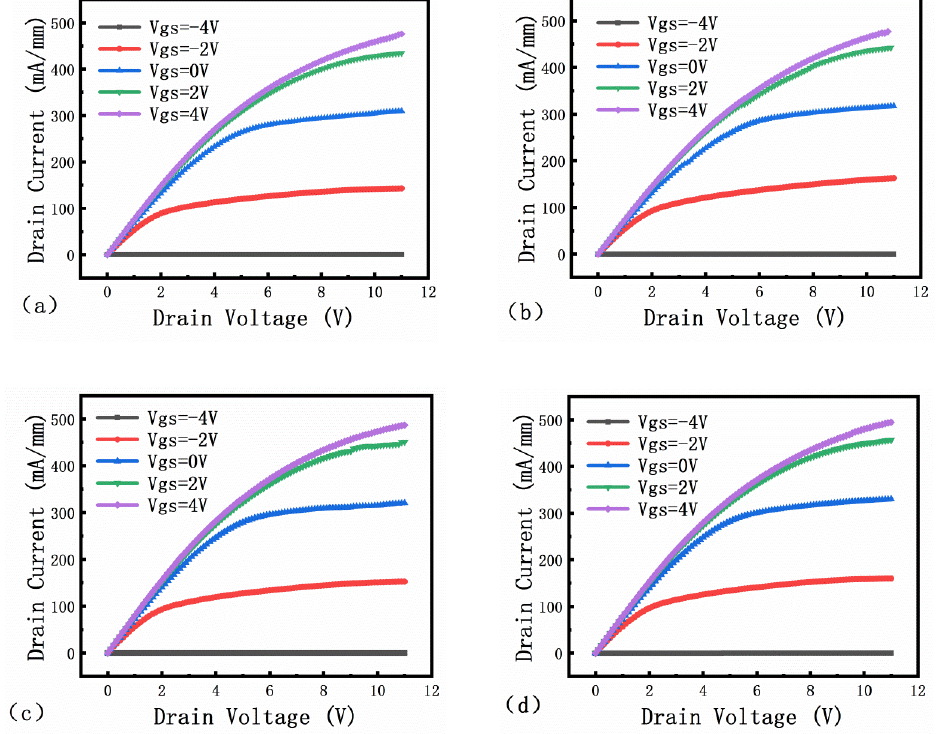
Figure 9. I–V characteristics of ( a ) no FP, ( b ) G-FP, ( c ) S-FP, ( d ) SG-FP.